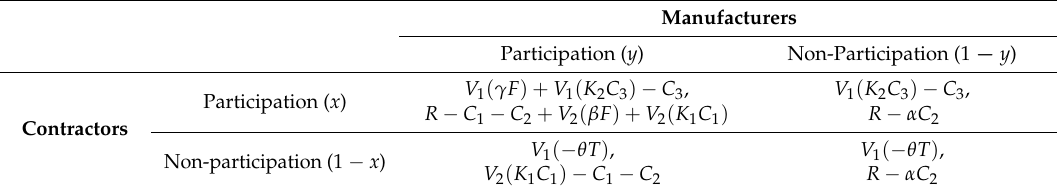
Table 1. The perceived payoff matrix between contractors and